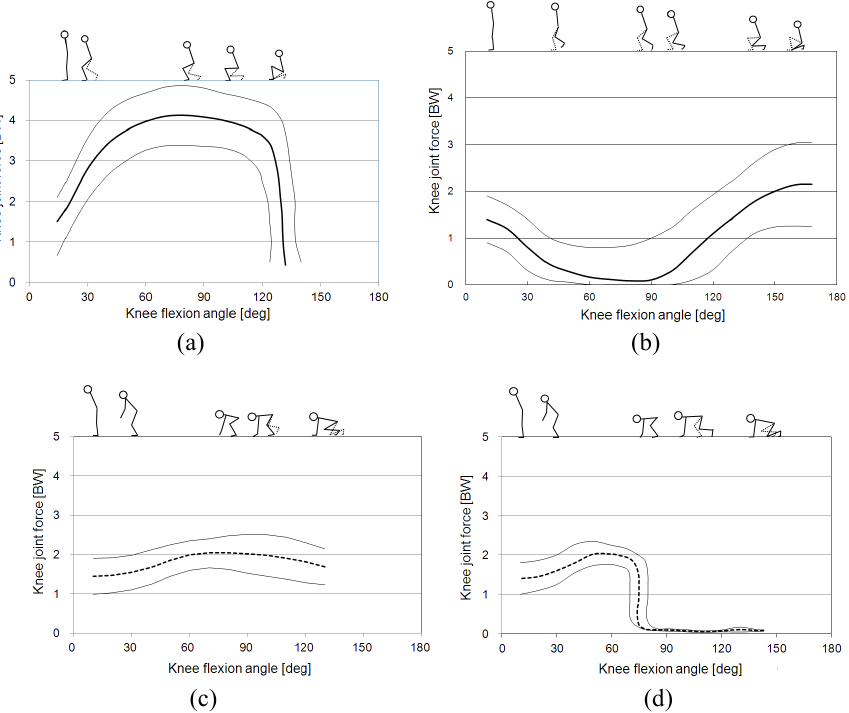
Fig.6 Curves of the mean and standard deviations in knee joint forces as a function of knee angle when rising with one foot